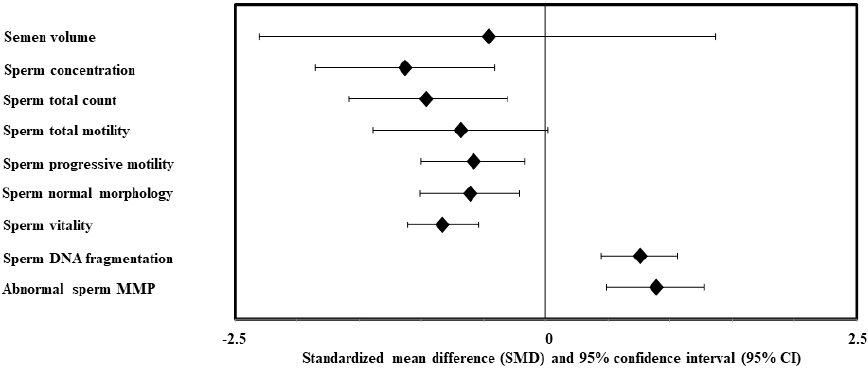
Figure 2. Summary of the Zhao and Pang [70] meta-analysis on the effects of metabolic syndrome (MetS) on semen parameters. MMP, mitochondrial membrane potential.